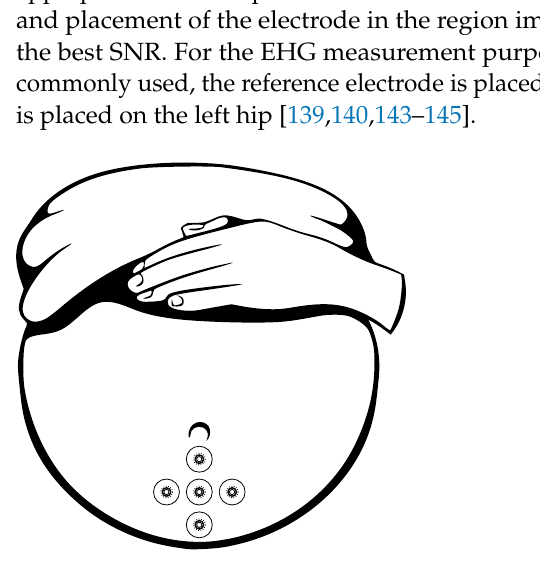
Figure 16. Configuration of location of the electrodes for the EHG